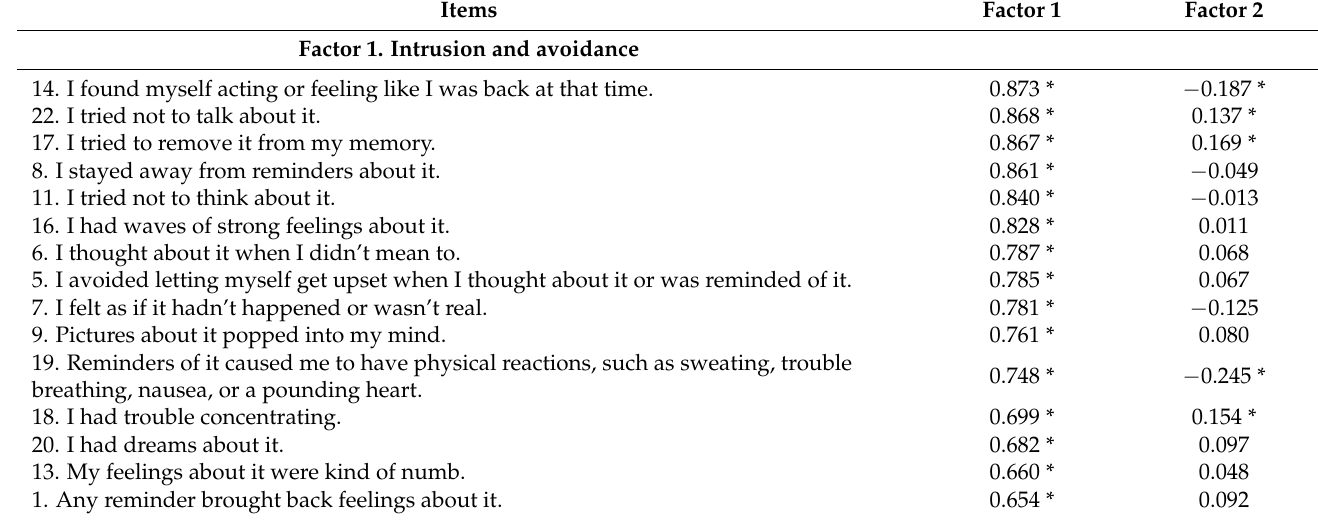
Table A1. The result of exploratory factor analysis based on a two-factor structure.